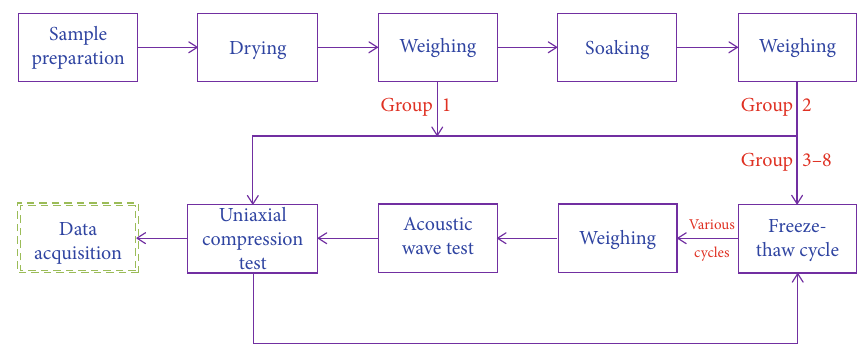
Figure 6: Flow diagram of the periodic freeze-thaw experiments.